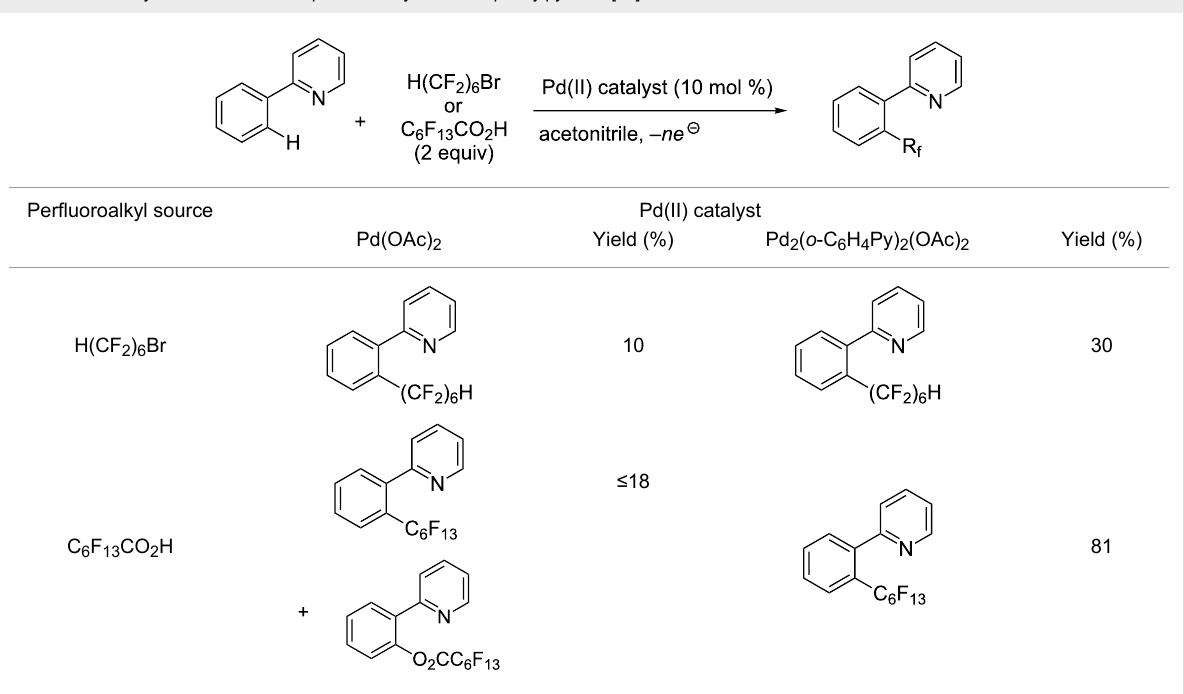
Table 9: Pd-catalyzed electrochemical perfluoroalkylation of 2-phenylpyridine [71].